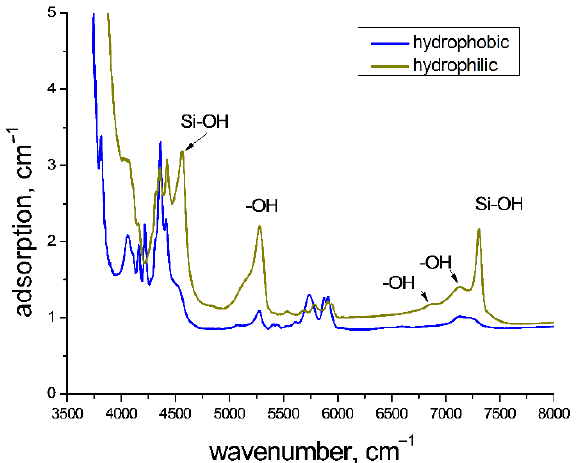
Figure 2. Adsorption spectra of hydrophobic and hydrophilic SiO 2 aerogels.